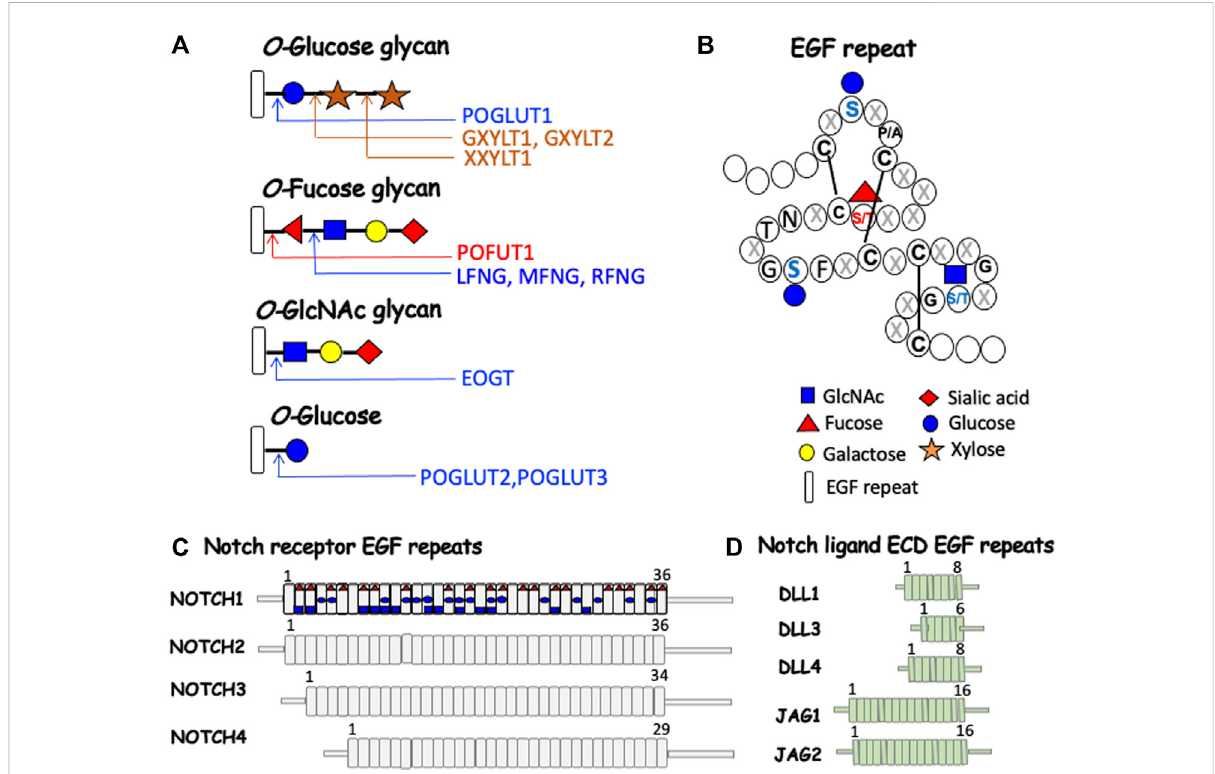
FIGURE 2 Notch receptor and Notch ligand glycosylation in mammals. (A) Each O-glycan predicted to be attached to an EGF repeat with an appropriate consensus sequenceisshown. (B) AgenericEGFrepeatof~40aminoacids(Campbelletal.,1990)withtherelevantsugarattachedattheconsensus site (Takeuchi et al., 2018a). Amino acids are shown by single letter code or X for any amino acid. The symbol for each sugar and an EGF repeat is shown in the key. The glycosyltransferases responsible for each sugar transfer are given. (C) NOTCH1-NOTCH4 ECDs are depicted with their respective number of EGF repeats, many of which can be modi fi ed by one or more O-glycans. The predicted O-glycan additions to mouse NOTCH1areindicatedbytherespectiveinitiatingsugar. (D) TheECDofcanonicalNotchligandswiththeirrespectivenumberofEGFrepeats,several of which can be modi fi ed by